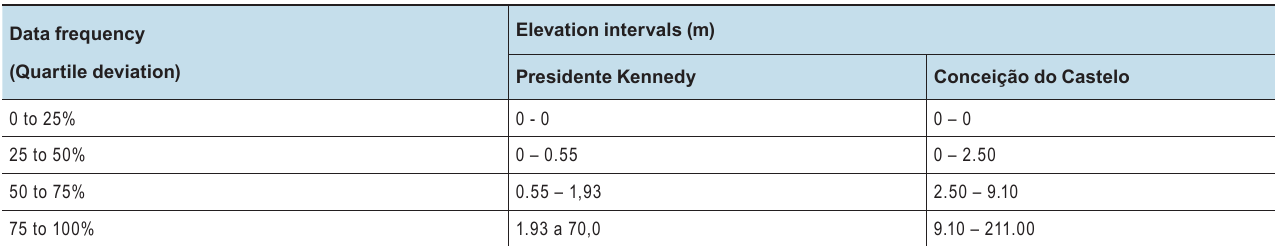
table 2 - Results of the HART quartile deviation of the studied